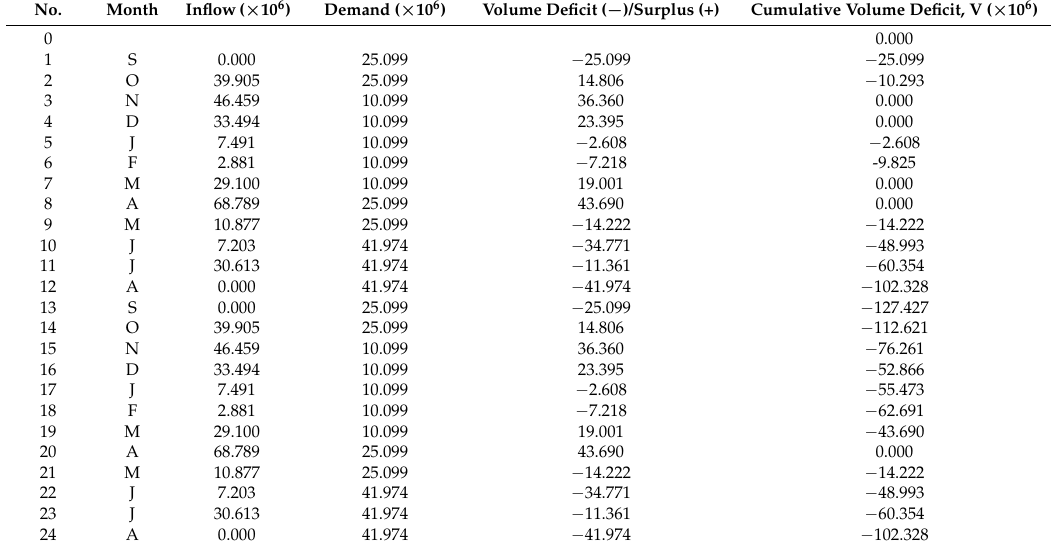
Table A2. Calculation of the required storage capacity, V (m 3 ), for hydrologic year 1991–1992, with the lowest yearly inflow of 276.811 × 10 6 m 3